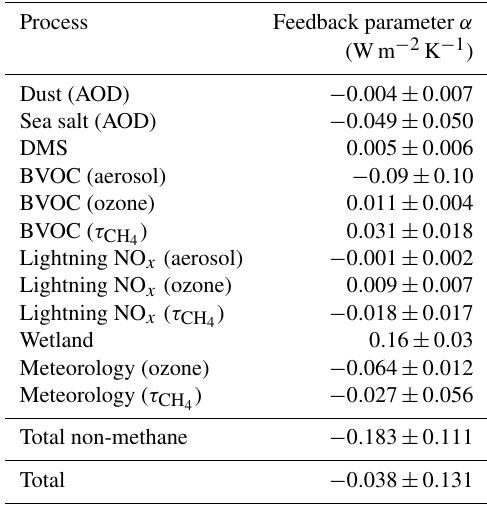
Table 15. Feedback parameters of all the aerosol and chemical pro- cesses addressed in this study. Uncertainties are the inter-model standard deviations.